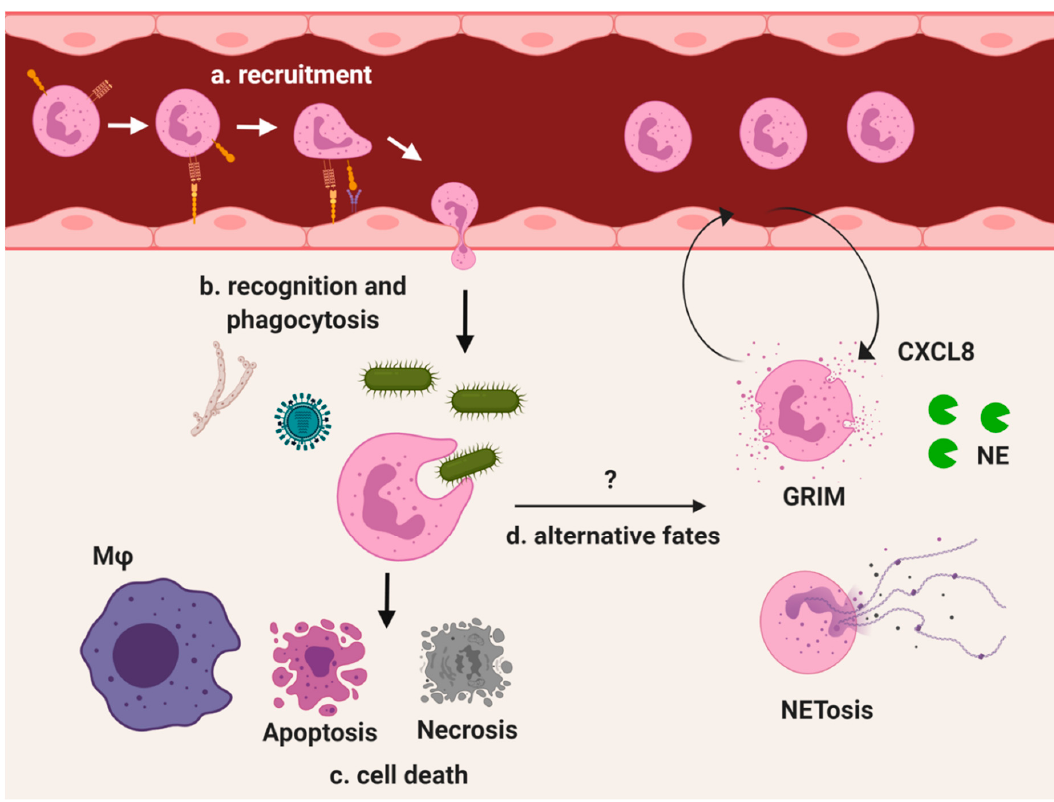
Figure 1. Overview of neutrophil recruitment and response in the lung. As a major